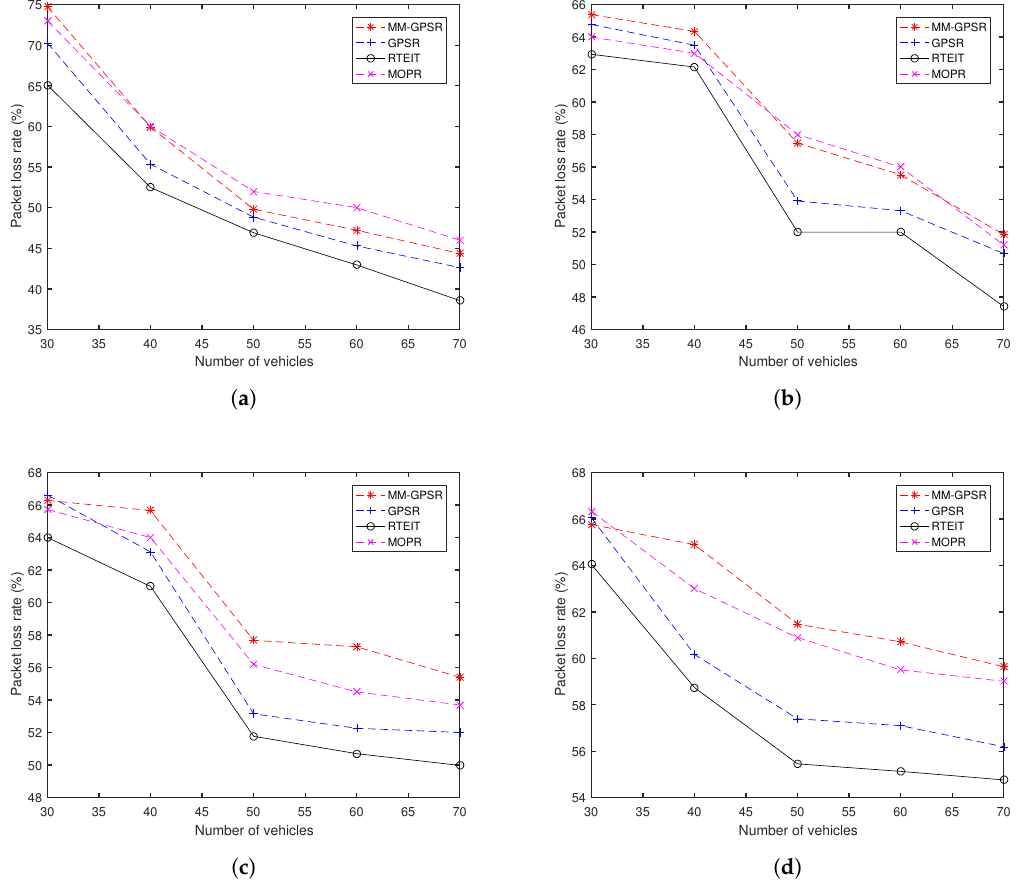
Figure 10. Packet loss rate for varying the number of vehicles and CBR connections: ( a ) 5 CBR connections; ( b ) 10 CBR connections; ( c ) 15 CBR connections; ( d ) 20 CBR